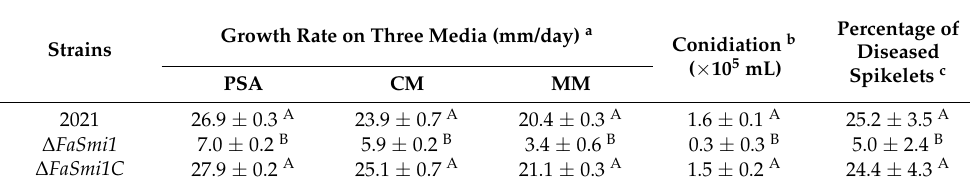
Table 1. Effect of FaSmi1 on mycelial growth, conidiation and virulence of F. asiaticum .